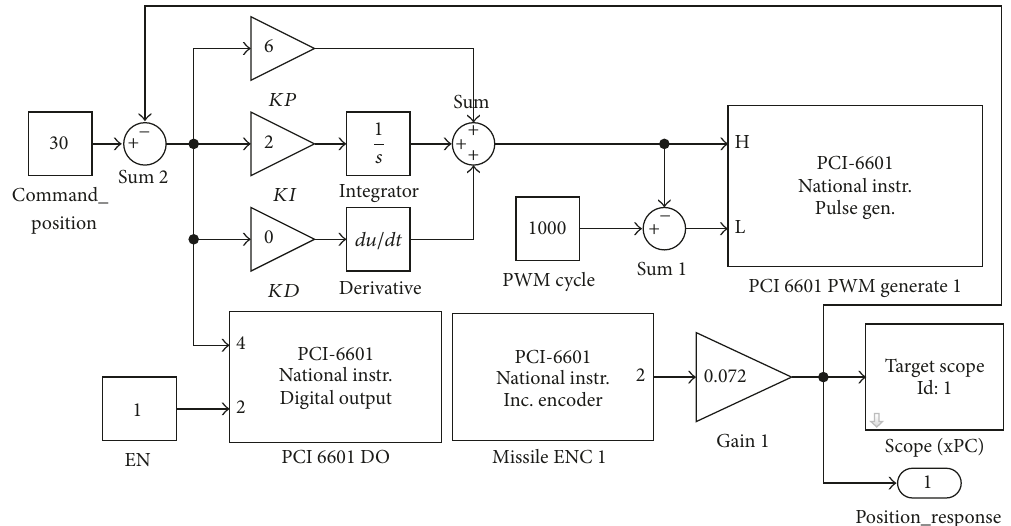
Figure 27: The block diagram of motor servo control for yaw angle response testing.